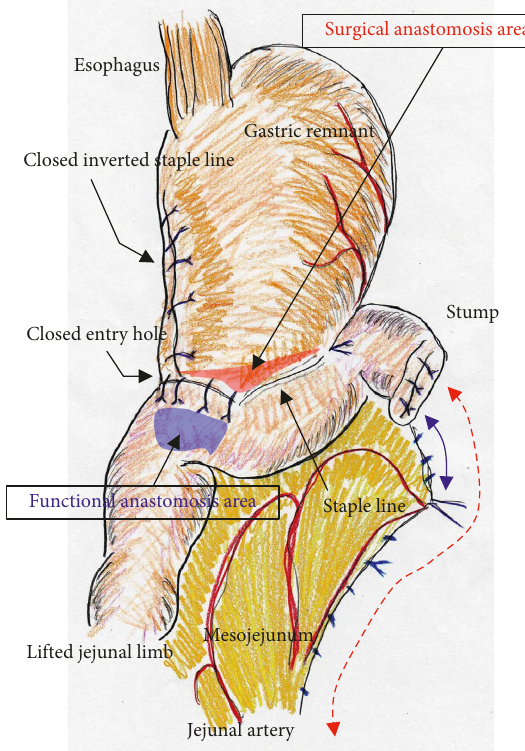
Figure 4: Overlap anastomosis involves linear-stapled re- construction using an isoperistaltic side-to-side approach. Func- tional and surgical anastomoses are distinct for overlap anastomosis, and postoperative passage depends on patency at the functional anastomosis (blue area), not on the length of the staple line at the surgical anastomosis (red area). The endostapler entry site was carefully closed with layer-to-layer sutures using running sutures in the mucosa and interrupted sutures in the seromuscular layer using absorbable monofilament suture. Longer staple lines may result in a postoperative pouch-like dilatation in the lifted jejunal limb; therefore, we set the length of the staple line at 35– 40mm. A defect behind the staples at the tip of endostapler was closed. Inverted staple lines were covered. Even subtle tension on the mesojejunum was avoided as much as possible by sacrificing the jejunum (blue solid arrow), and a well-defined mesojejunum in the lifted jejunal limb (red dotted arrow) effectively preserved the mesenteric autonomic nerves. Mesenteric gaps were closed